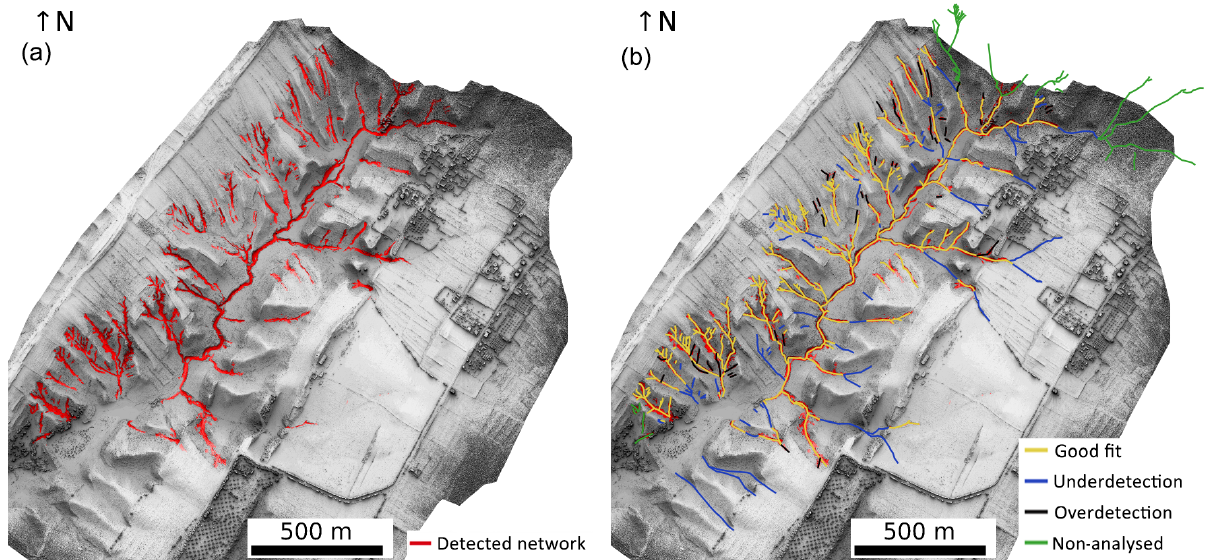
Figure 9. Results of the gully mapping algorithm. (a) The gully network identified from the kite DEM is represented in red and superimposed on the shaded DEM. (b) Comparison with ground survey: yellow lines represent the part of the network correctly detected by our algorithm; black thick lines represent gullies detected by our algorithm where no gully was surveyed in the field (overdetection); blue lines represent gullies that were identified on the ground but not detected by our algorithm (underdetection); green lines represent gullies that were identified on ground but not used for error statistics, because they were outside the Kamech catchment area or their heads were outside of the area covered by the kite DEM.